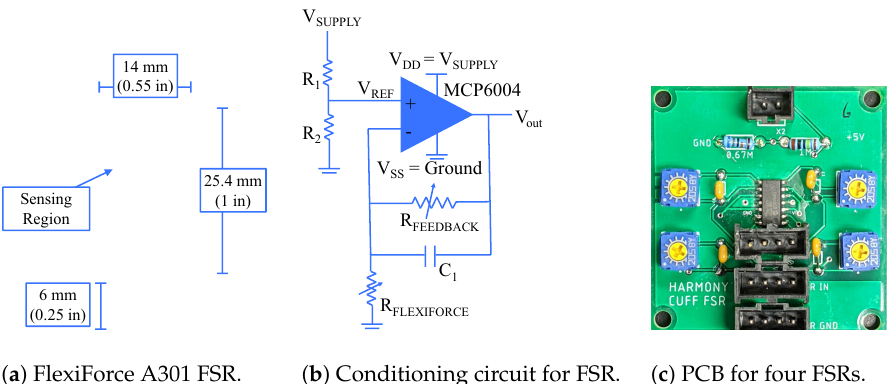
Figure 2. The force-sensing resistors (FSRs) are made from piezoresistive material that correlates the force applied on the sensing surface to the resistance of the sensor in an electrical circuit. This circuit requires the use of an operational amplifier. A printed circuit board has been designed for the implementation of the circuit shown in Figure 2b, such that each printed circuit board (PCB) accommodates four FSRs.